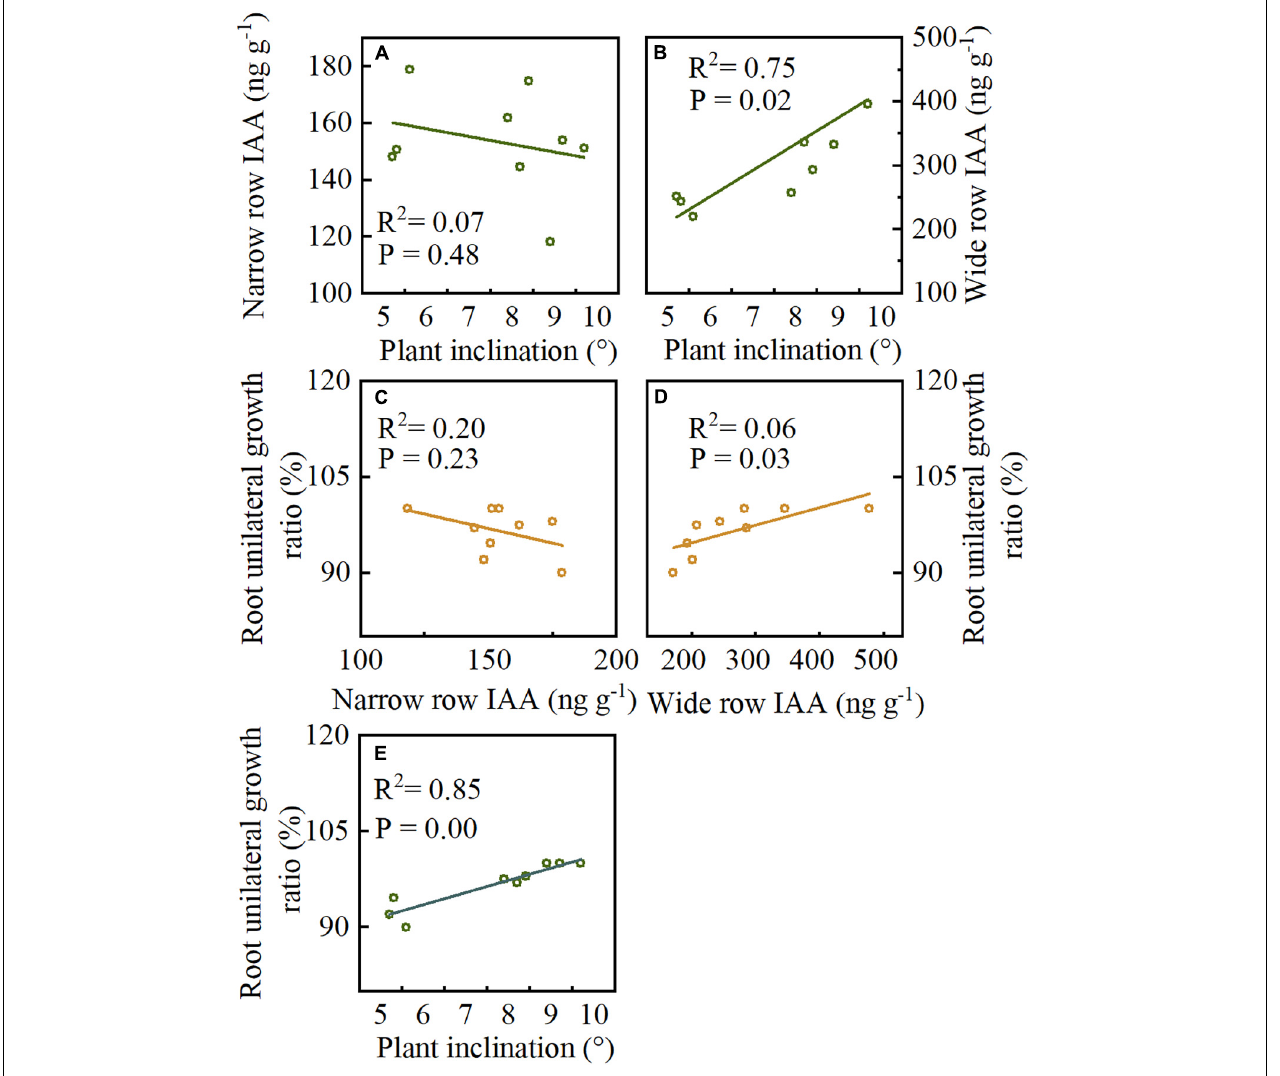
FIGURE 9 | The correlations between plant inclination, IAA, and unilateral root growth ratio were analyzed in Study 1 (2020). (A,B) The correlations between narrow row IAA, wide row IAA and plant inclination. (C,D) The correlations between narrow row IAA, wide row IAA and root unilateral growth ratio. (E) The correlations between plant inclination and root unilateral growth ratio. p < 0.05 by Pearson’s correlations. Data forms treatments of I 20 , I 40 , and I 60 , n =